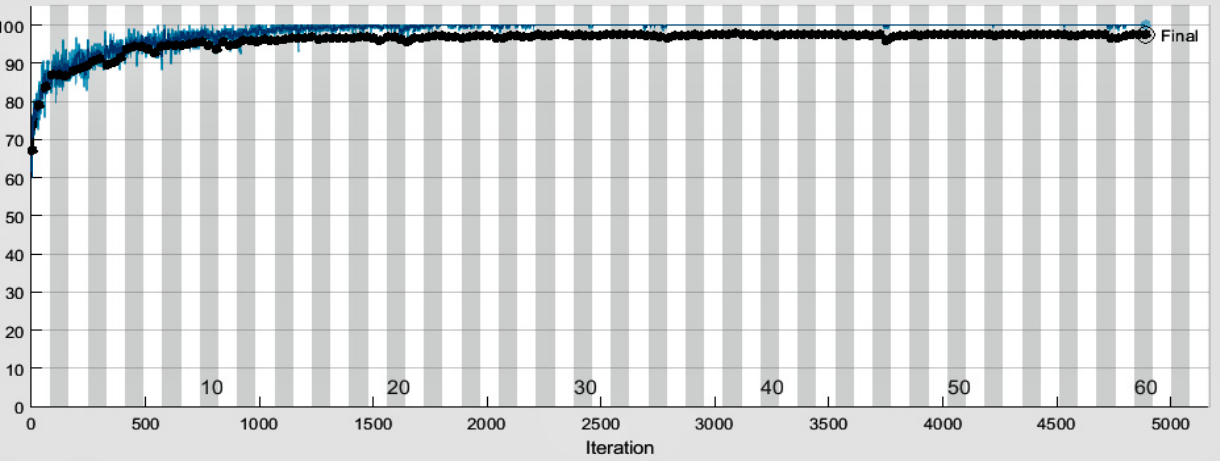
Figure 5. Training and validation loss of proposed CovidDetNet framework (black line shows testing loss whereas red line shows training loss). The loss function indicates how well the framework can predict the dataset. The loss and accuracy of our model after epoch 47 approximately remains the same, which shows that our model is predicting COVID-19 with higher accuracy even at lower epochs than 60. The training and validation process of the proposed CovidDetNet approach is shown in Figure 4 and the confusion matrix for the testing phase of the CovidDetNet framework for COVID-19 infection detection is shown in Table 4. The proposed CovidDetNet archi- tecture misclassified 109 radiographs out of 4547, of those, 48 COVID-19 images, 50 im- ages for normal, and 11 images for viral pneumonia. The proposed CovidDetNet frame- work has higher TN and TP values, as well as lower FN and FP values, as shown by the confusion matrix. As a result, the suggested method is capable of accurately classifying COVID-19 situations.